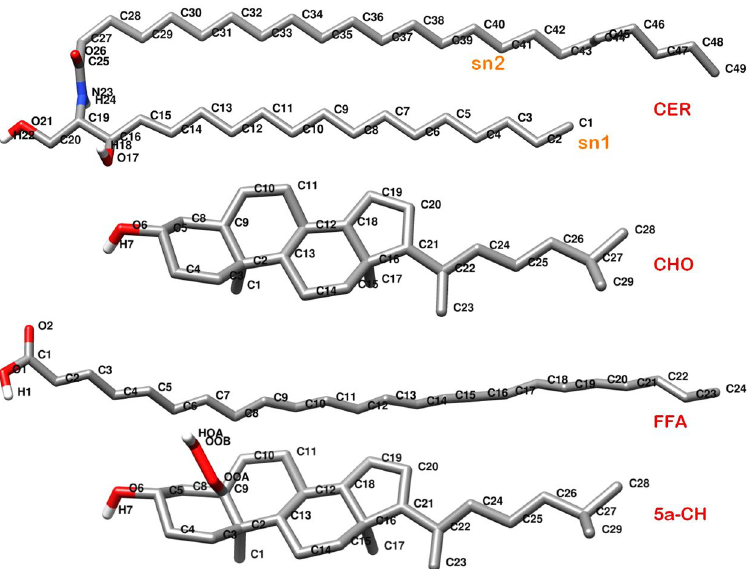
Figure 1. Molecular structure of individual lipids, i.e. Ceramide NS (CER), Cholesterol (CHO), Free fatty acid (FFA) and 5 α -ChOOH (5 α -CH) used in simulations. Oxygen, Hydrogen, Carbon and Nitrogen atoms are shown in red, white, grey and blue color